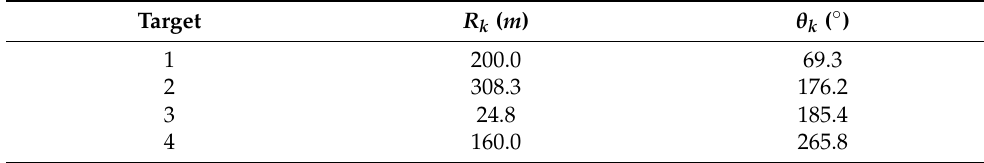
Table 3. Multi-target position parameters.